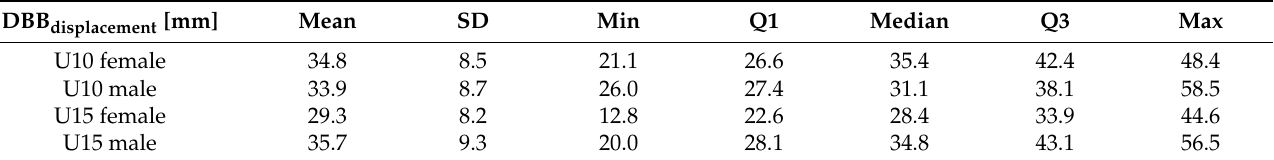
Table 2. DBB displacement reference data for female and male U10 and U15 competitive alpine skiers.